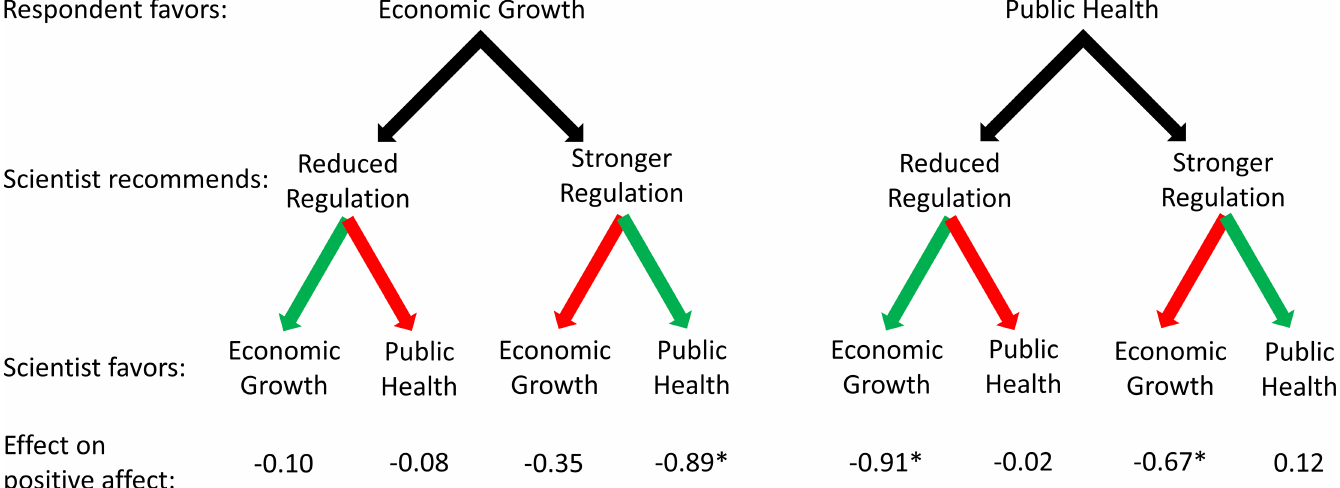
Fig 3. Effects of scientists’ policy recommendations and expressedvalues on respondents’ positive affect toward them. Effects are relative to a scientist not expressinga preferencefor particularvalues and are net of control variables; see Table 1. Green arrows are used when the scientist’s recommendation coincideswith the scientist’s values; red arrows are used when the scientist’s recommendationconflicts with the scientist’s values.